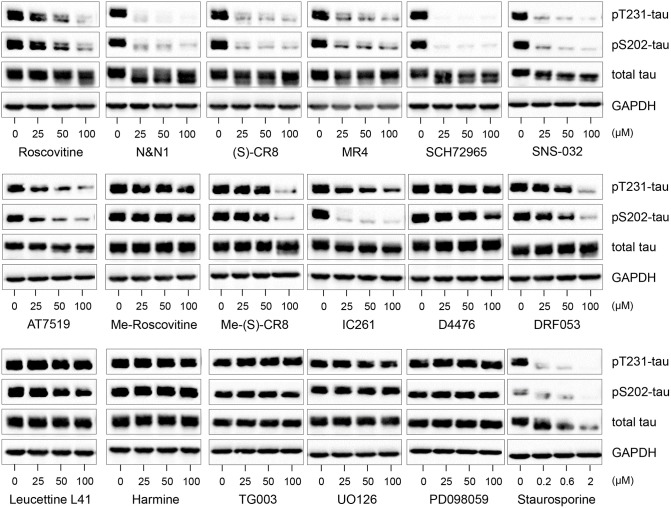
Decreased tau phosphorylation by roscovitine is due to its inhibition of cyclin-dependent kinases (CDKs) and not other kinase targets. SH-SY5Y-(P301L) cells were exposed for 6 h to pharmacological inhibitors of CDKs (roscovitine, N&N1, (S)-CR8, MR4, SCH72965, SNS-032, AT7519), to kinase inactive derivatives of roscovitine (N6-methyl-roscovitine) or CR8 (N6-methyl-CR8), CK1 (IC261, D4476, DRF053), DYRKs/CLKs (Leucettine L41, harmine, TG003), MEK1 (UO126, PD098059), to a general kinase inhibitor (staurosporine). All drugs were tested at 25, 50, and 100 μM, except staurosporine (0.2, 0.6, and 2 μM). Cells were harvested and proteins were resolved by SDS-PAGE followed by western blotting with antibodies to pThr231 (Mab RZ3), pSer202 (Mab CP13), and T-tau (DA31). α-GAPDH was used as a loading control.